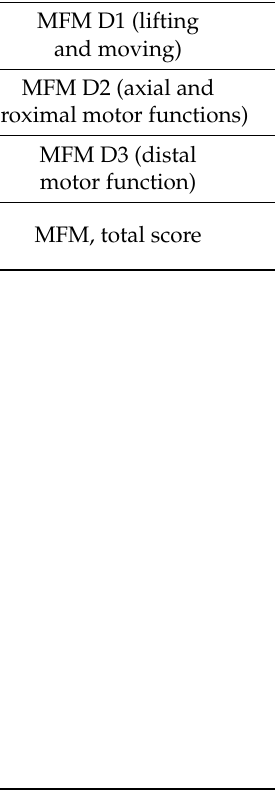
Table 4. Correlation analysis (r Spearman ) of the MFM scale and the results of MRI of the muscles of the pelvic girdle, thighs, and lower legs (Mercuri scale assessment of fibro-fat degeneration) in patients incapable of independent movement. Pelvic Muscles MRI Femoral Muscles MRI Calf Muscles MRI MRI Scores, Total